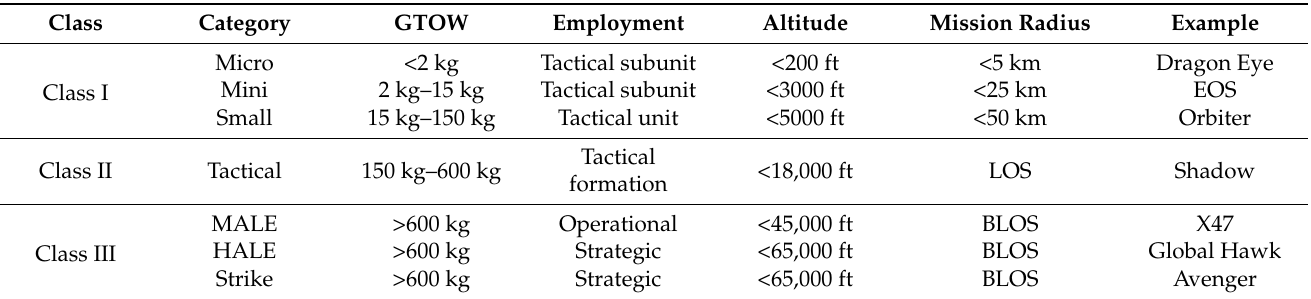
Table 2. NATO UAV